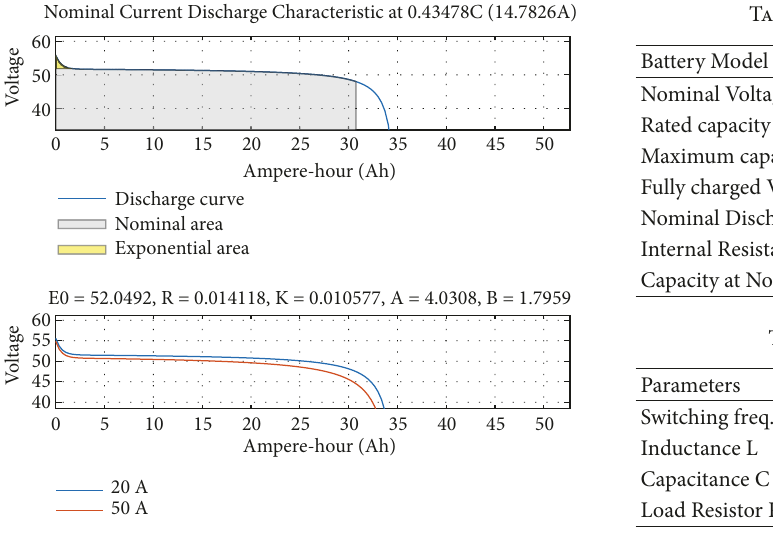
Figure 14: Simulation discharge curves for the Li-ion battery.